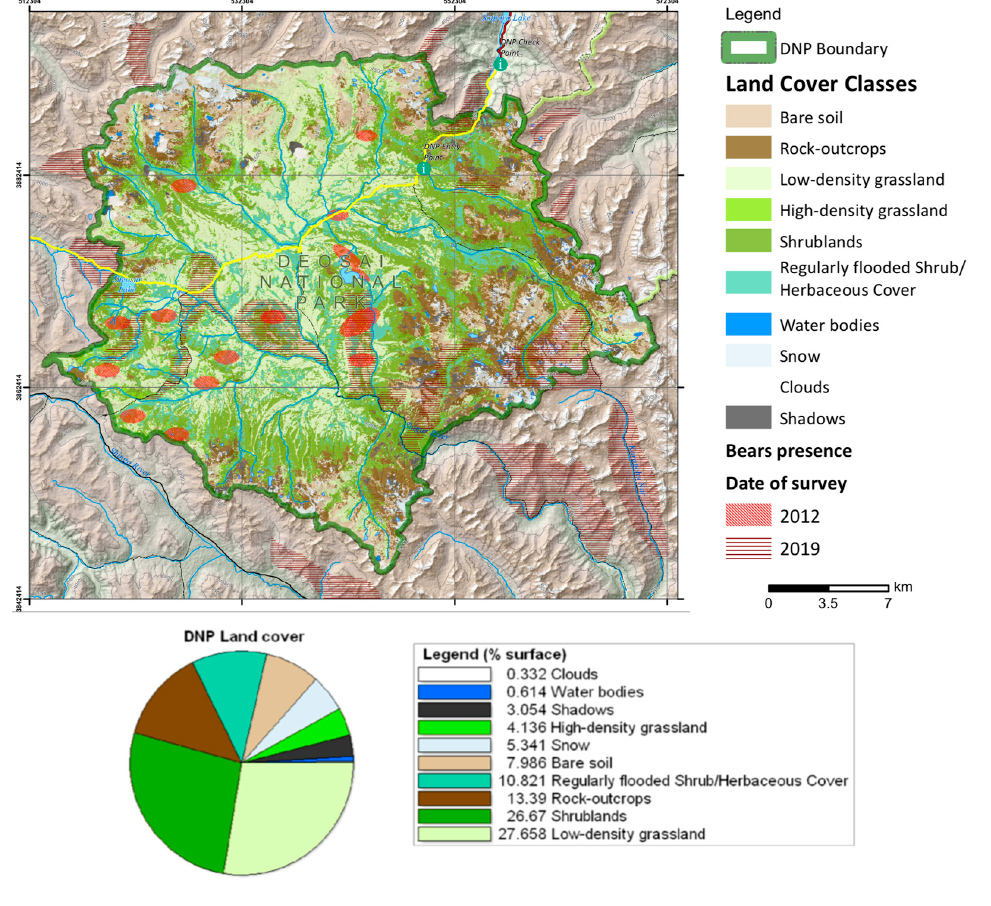
Figure 3. The Land Cover map of the DNP.